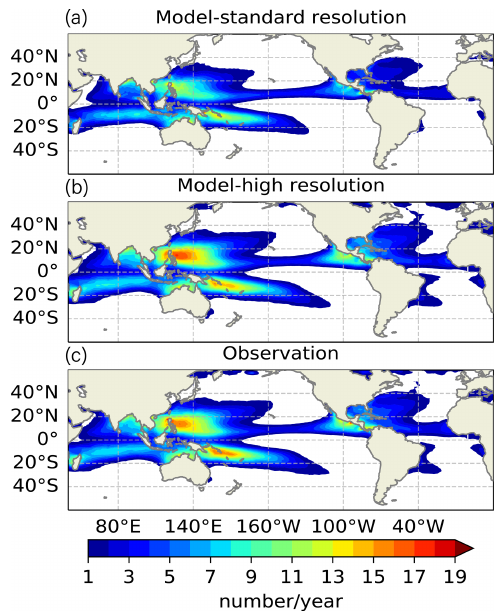
Figure 13. Global GPI pattern based on the multi-model mean of the (a) standard-resolution GCMs and (b) high-resolution GCMs and (c) ERA-Interim